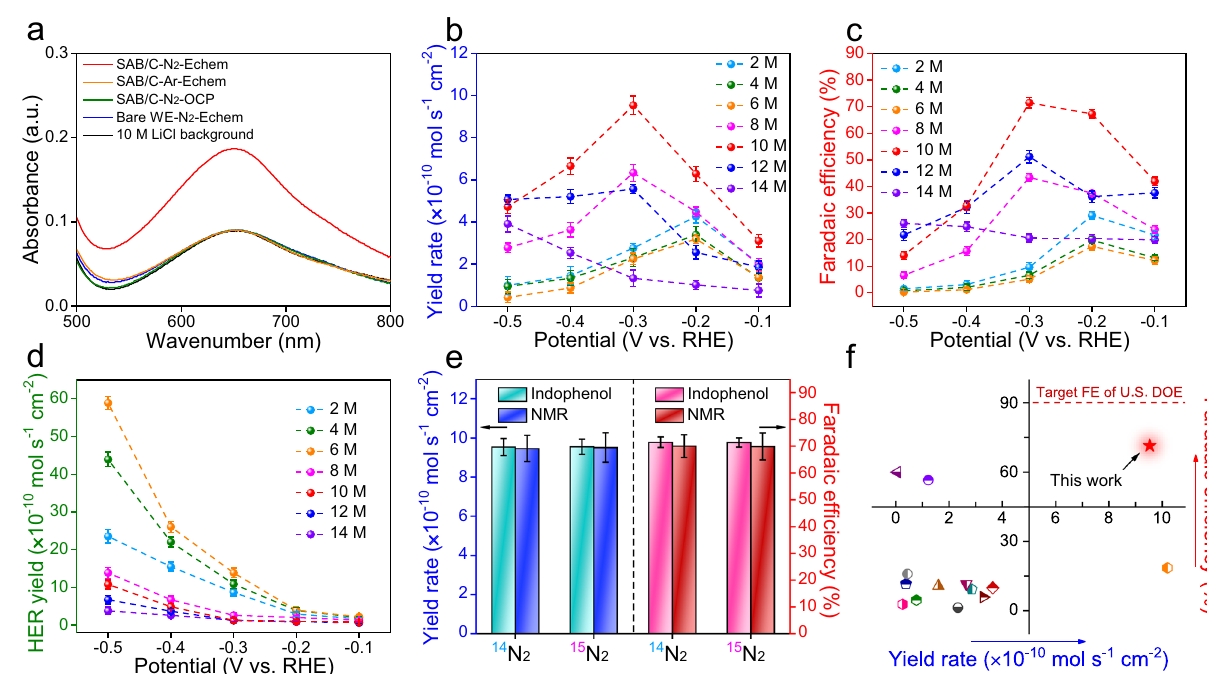
Fig. 4 Electroreduction of N 2 to NH 3 under ambient conditions. a Ultraviolet-visible absorption spectra of the electrolytes under different conditions. No apparent NH 3 was detected for the control experiments with Ar-saturated electrolyte under Echem, N 2 -saturated electrolyte under open circuit potential (OCP), or bare working electrode (WE) without single-atom boron-decorated carbon catalyst (SAB/C) in N 2 -saturated electrolyte under Echem. b NH 3 yield rates, c corresponding Faradaic ef fi ciencies, and d HER yield rates in different systems. e Comparison of the Faradaic ef fi ciency and NH 3 yield rate using different feeding gases for NRR at − 0.3 V vs. RHE either by indophenol or nuclear magnetic resonance (NMR) method. The error bars correspond to the standard deviations of measurements of three separately prepared samples under the same conditions. f Comparison of our results with state-of-the- art noble-metal-free electrocatalysts in terms of yield and Faradaic ef fi ciency (FE); detailed data are provided in Supplementary Table 4. The Faradaic ef fi ciency of our work is very close to the target set by the U.S. Department of Energy (DOE) ’ s ARPA-E REFUEL